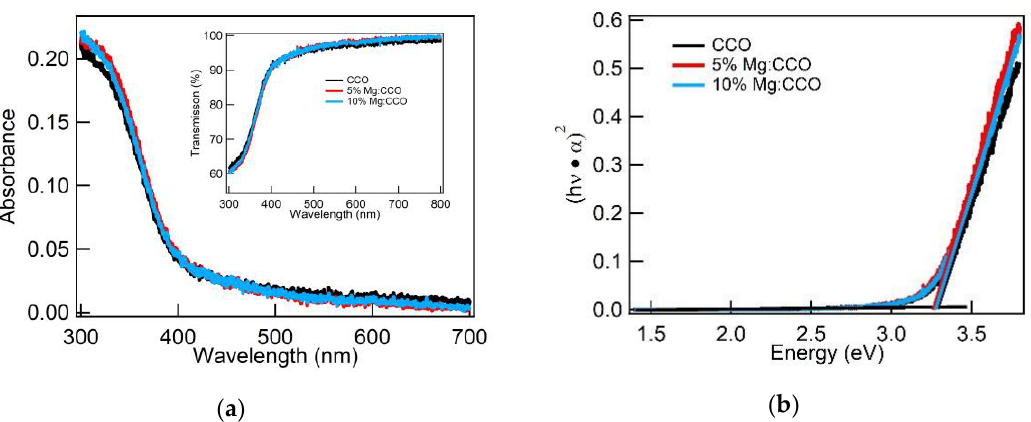
Figure 7. SEM images of ( a ) CCO, ( b ) 5% Mg:CCO, and ( c ) 10% Mg:CCO films on ITO substrates.